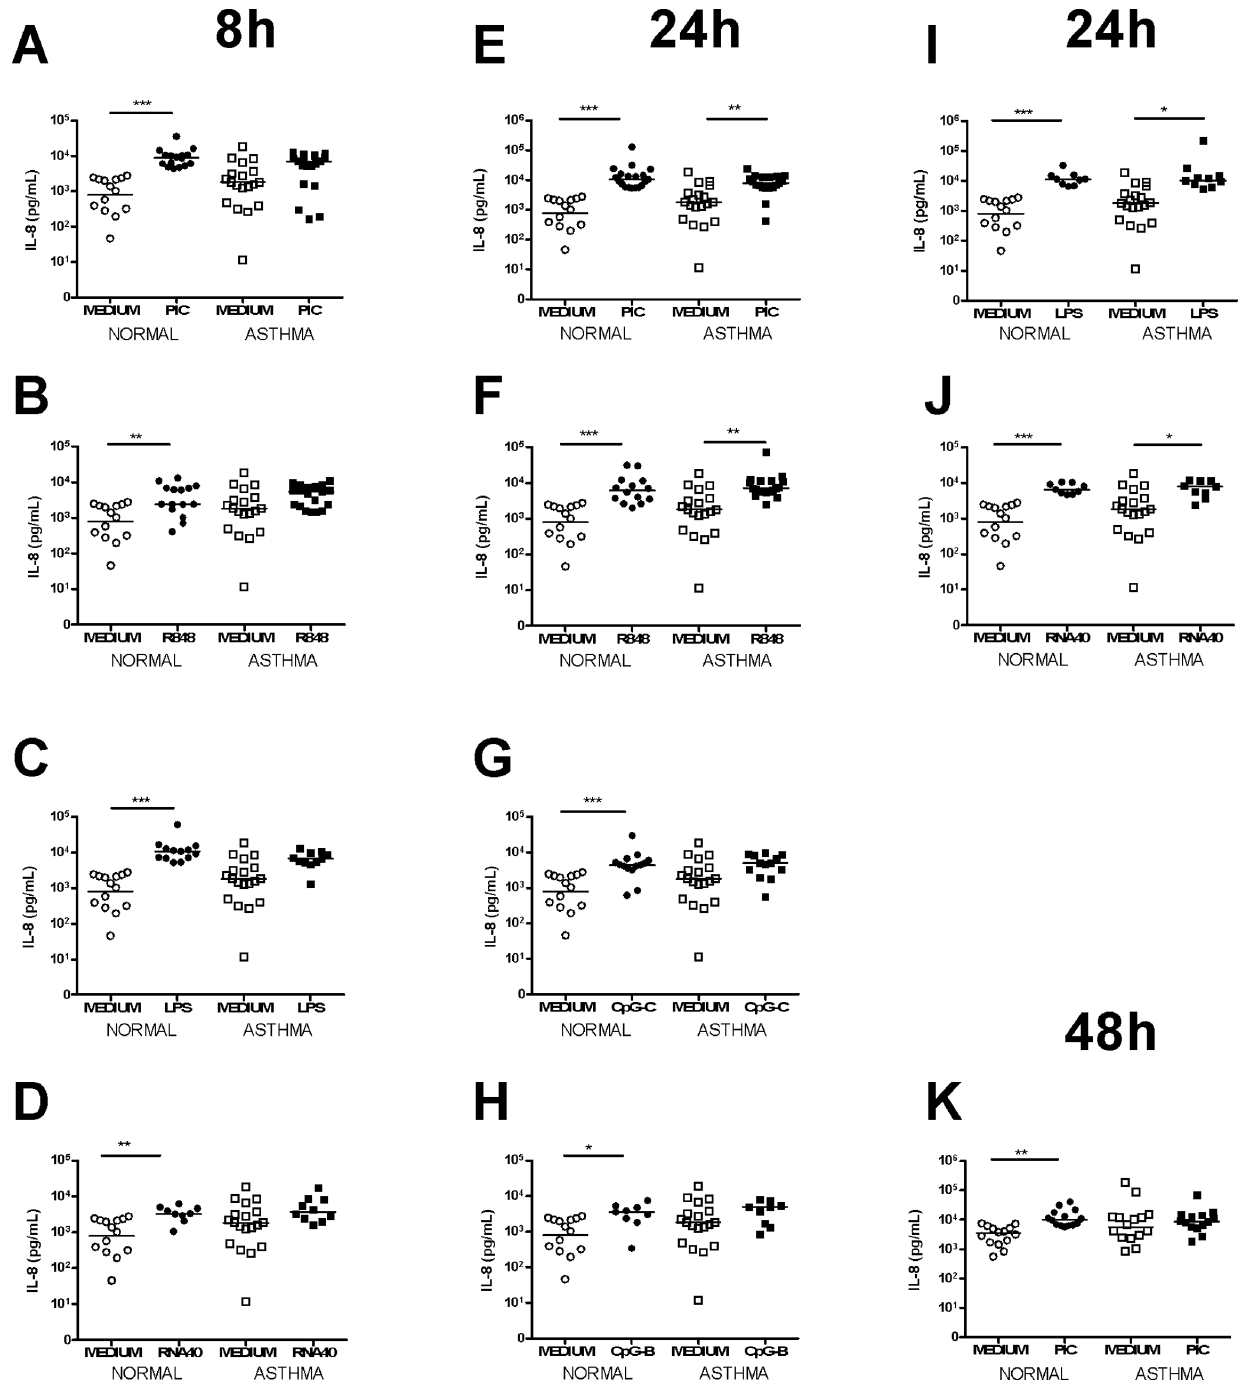
Figure 7. IL-8 induction following TLR stimulation in PBMCs. Graphs depict IL-8 production at 8 h following stimulation with PIC [A], R848 [B], LPS [C] and RNA40 [D], 24 h following PIC [E], R848 [F], CpG-C-ODN [G], CpG-B-ODN [H], LPS [I] and RNA40 [J] and 48 h following PIC [K]. Squares represent asthmatics, circles represent non-asthmatics. *=p , 0.05, **=p , 0.01, ***=p , 0.001.